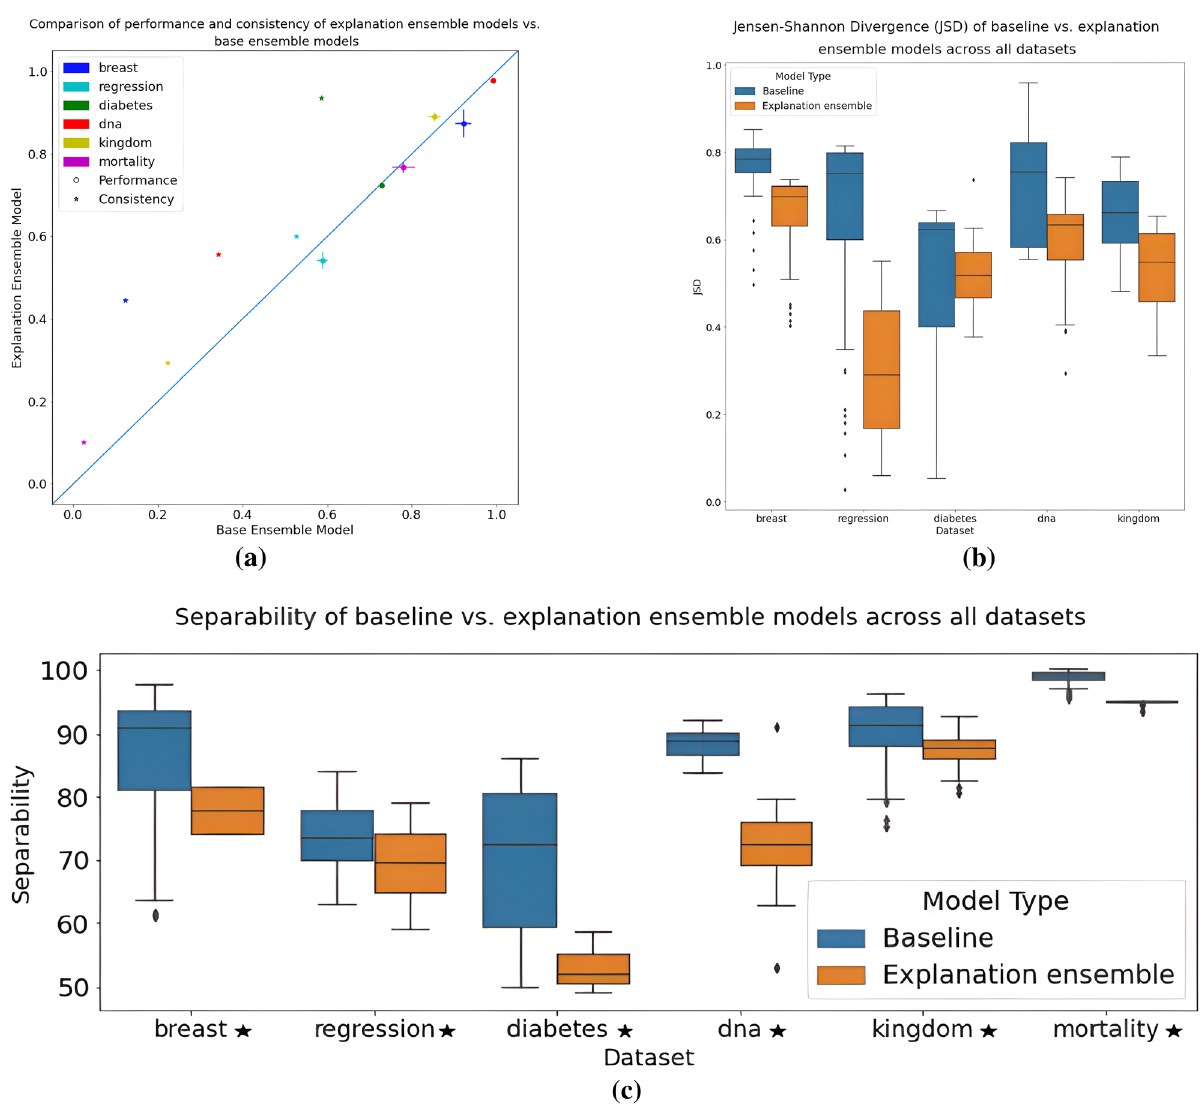
Figure 2. Figures comparing the explanation consistency C ( a ), JSD explanations consistency C JSD ( b ), and explanation separability ( c ) between baseline models and our proposed explanation ensembles across all tasks tested. Stars indicate datasets where the difference between the two architectures is statistically significant, following the results of a Mann-Whitney U